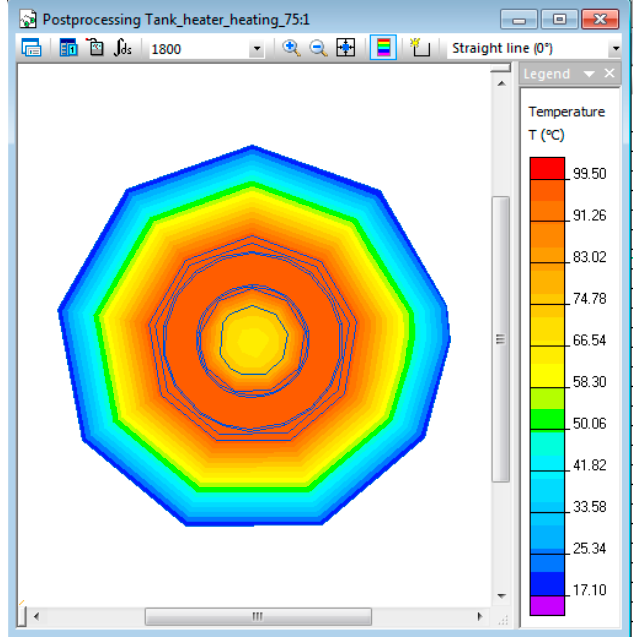
Energies 2021 , 14 , 6024 Figure 10. The AMD temperature distribution. Figure 10. The AMD temperature distribution.